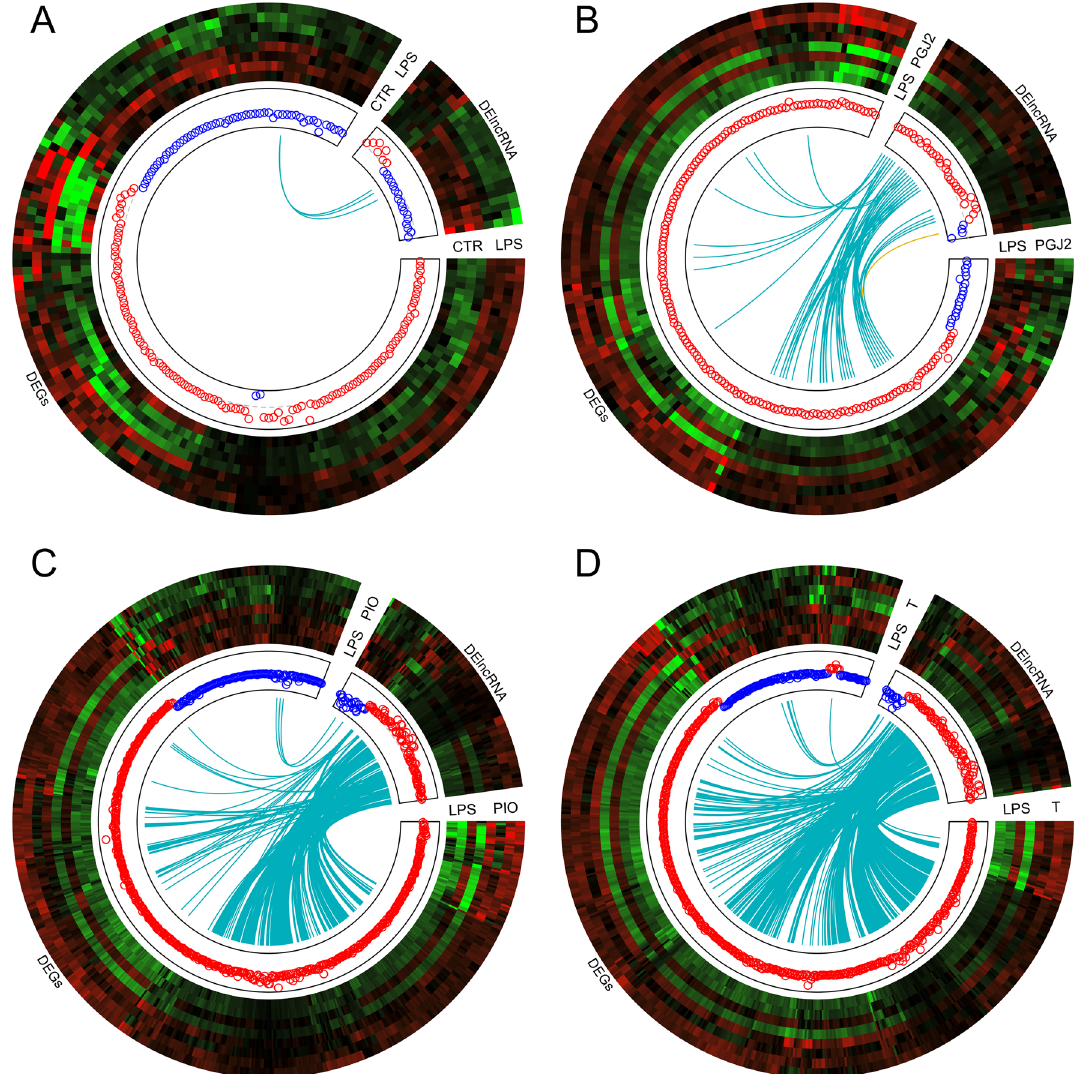
Figure 2. Circular heatmaps presenting the associations between differentially expressed genes (DEGs) and differentially expressed long non-coding RNAs (DElncRNAs) in endometrial tissues treated with LPS ( A ), PPARγ agonists—PGJ 2 ( B ) or pioglitazone ( C ) and antagonist ( D ). Each circle consists of eight upper tracks presenting the normalized (Z-score; red-green scale) expression profiles for DEGs and DElncRNAs in two separate blocks. The middle tracks describe the expression of upregulated (red) and downregulated (blue) genes in the each compared group. The innermost track presents the correlations between the co-expressed DEGs and DElncRNAs, where blue links depict positive correlations (> 0.9) and orange links depict negative Euclidean correlations (< − 0.9). The plots were generated in circlize R bioconductor